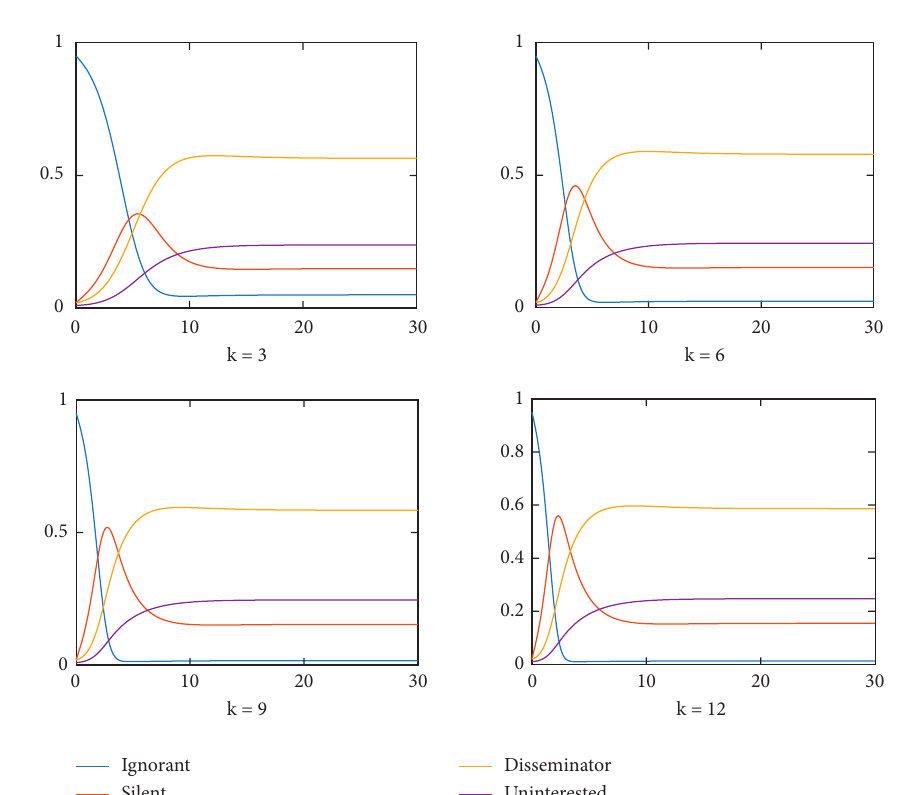
Figure 5: Information dissemination in small world network with different k values.